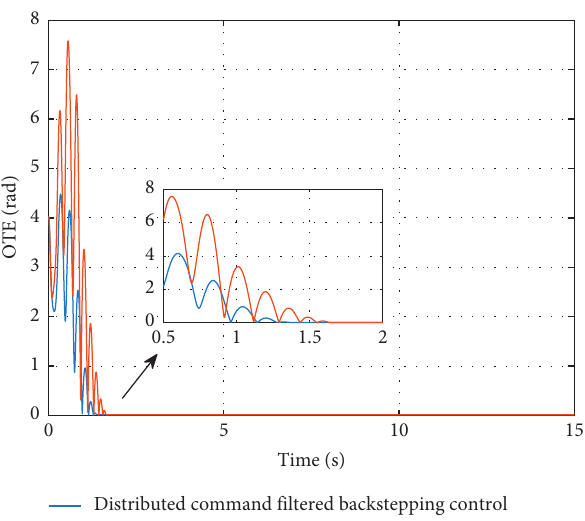
� 1; ... ; 6 under measurement noises. i and y d ; i